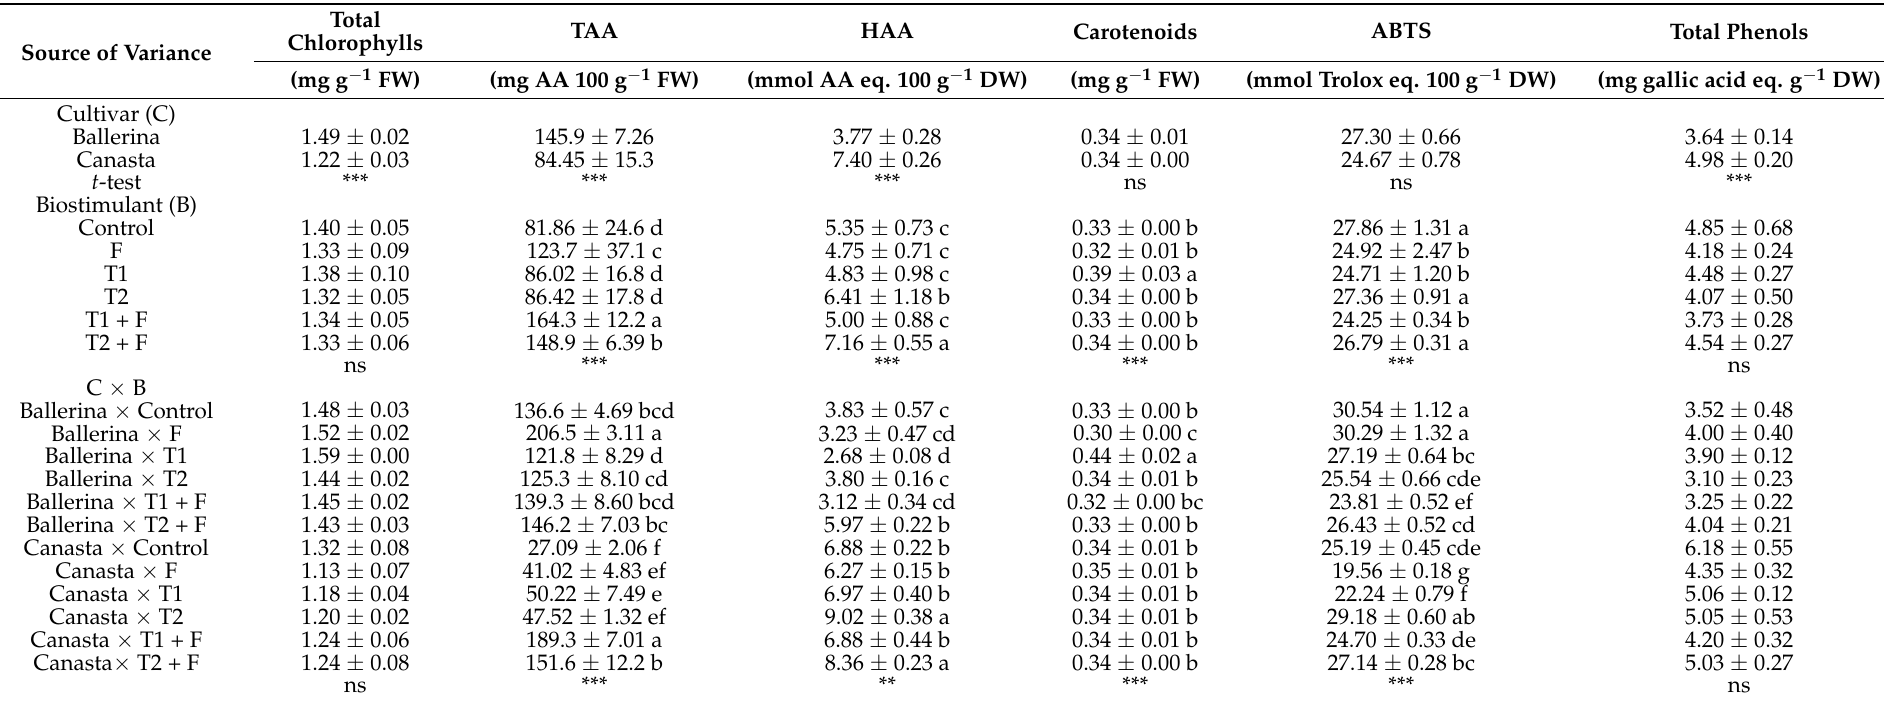
Table 4. Leaf pigments (chlorophylls and carotenoids), total ascorbic acid (TAA), hydrophilic antioxidant activity (HAA), ABTS antioxidant activity (ABTS) and total phenols of ‘Canasta’ and ‘Ballerina’ lettuce as influenced by the biostimulant